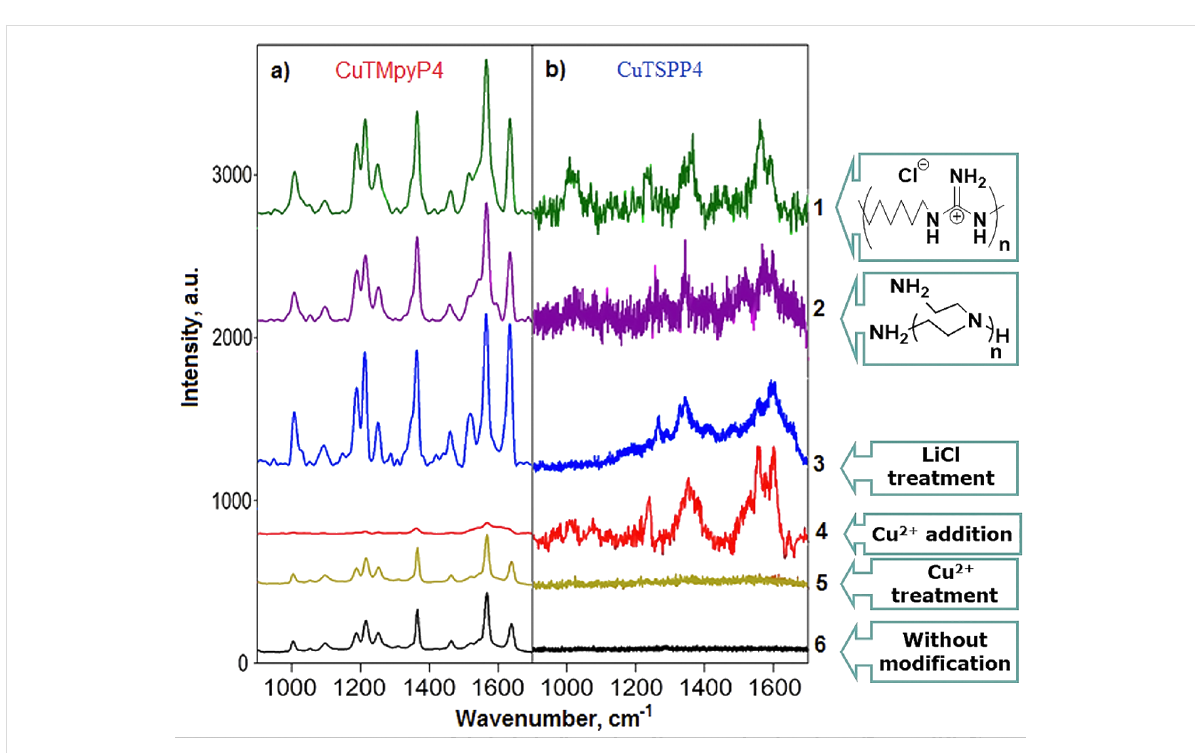
Figure 7: SERS spectra of (a) CuTMpyP4 and (b) CuTSPP4 drop-cast from 10 − 6 M solution onto the SERS substrate modified with (1) PHMG, (2) PEI, (3) LiCl, (4) Cu 2+ (added into analyte solution), (5) Cu 2+ (surface treatment), and onto (6) the unmodified plasmonic